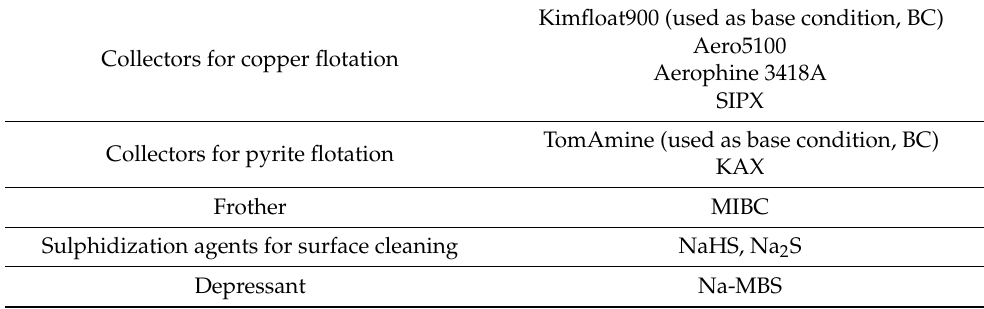
Table 3. Reagent scheme used in the flotation